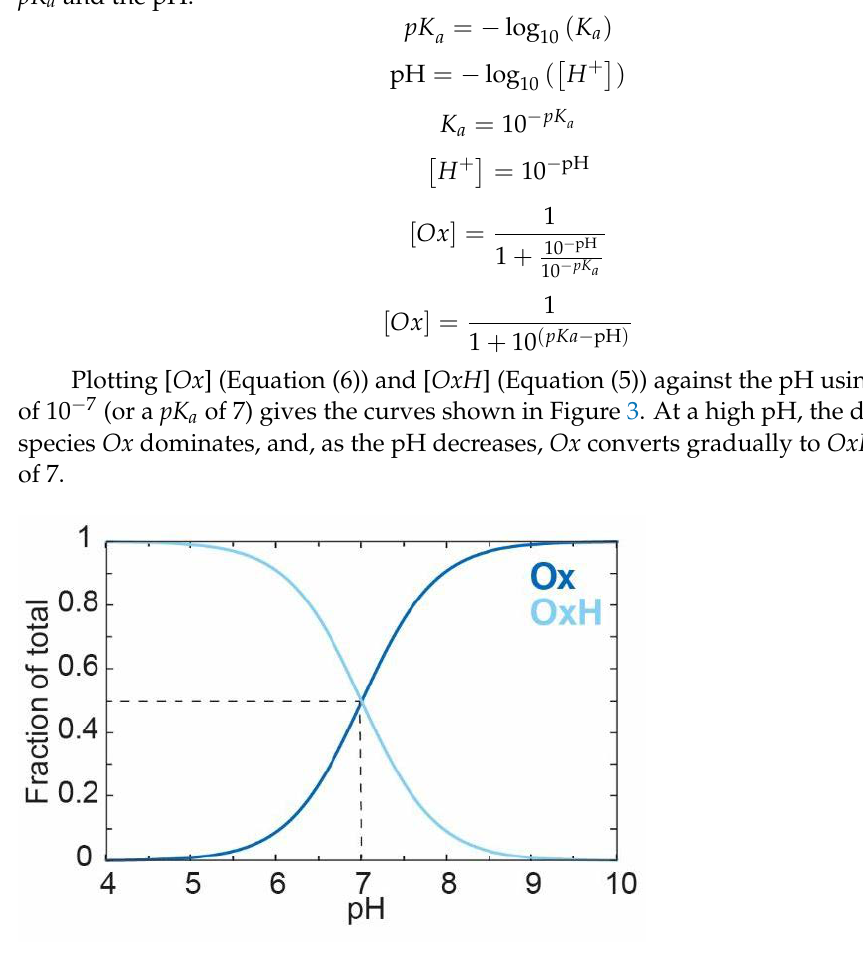
Figure 3. Variation of the fraction (out of 1) of deprotonated ( Ox , dark blue) and protonated ( OxH , light blue) species as a function of the pH. The curves were obtained using Equations (5) and (6) for an acid dissociation constant and a pK a value of